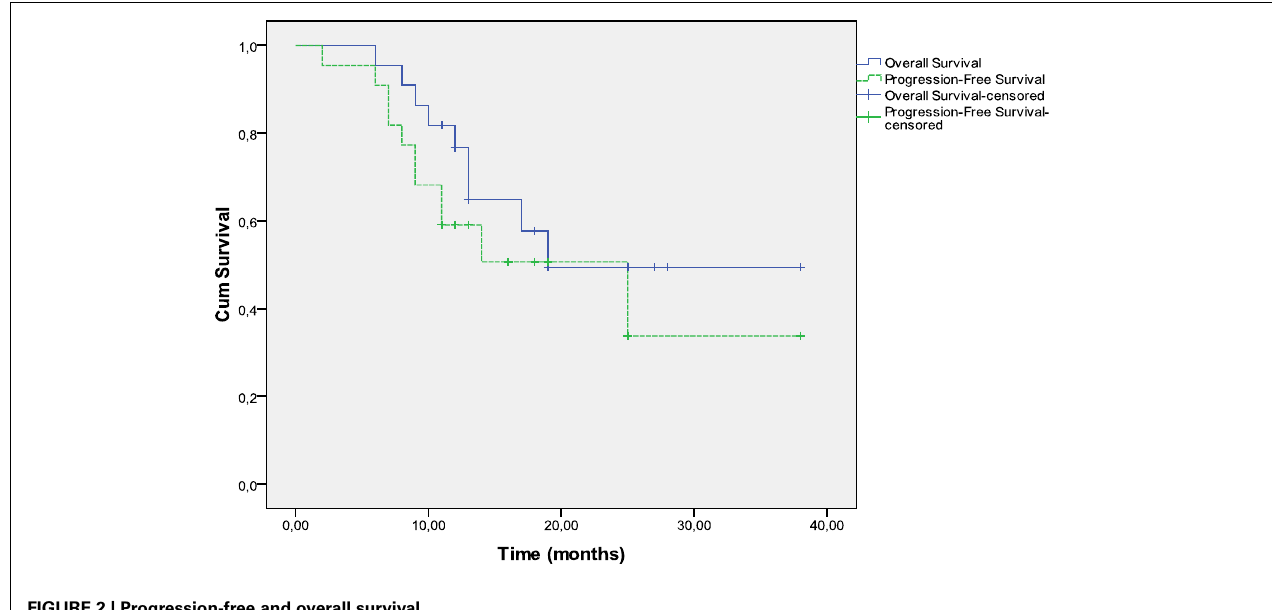
FIGURE 2 | Progression-free and overall